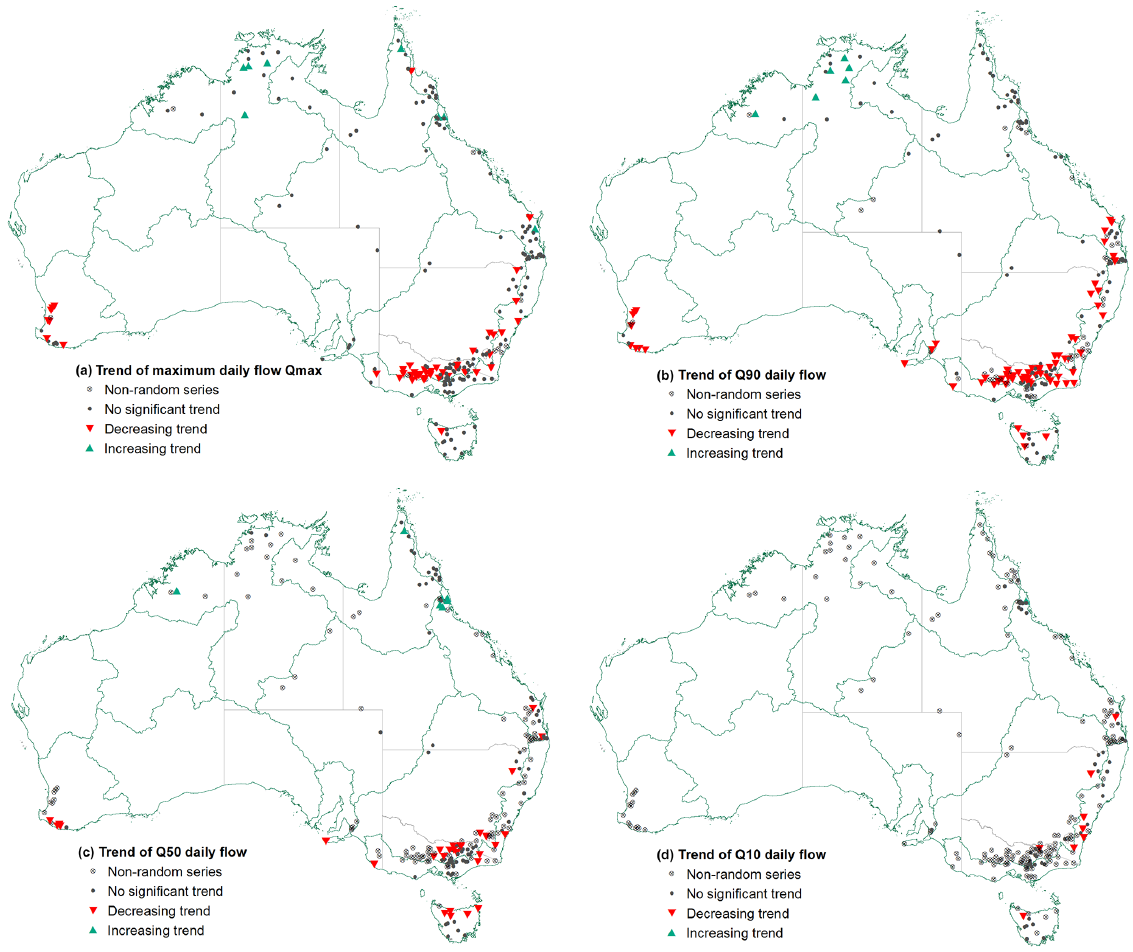
Figure 8. Maps showing trends of daily flow in various magnitude categories (a) maximum daily flow Q Max ; (b) Q 90 daily flow; (c) Q 50 daily flow; (d) Q 10 daily flow at 10% significant level ( p <